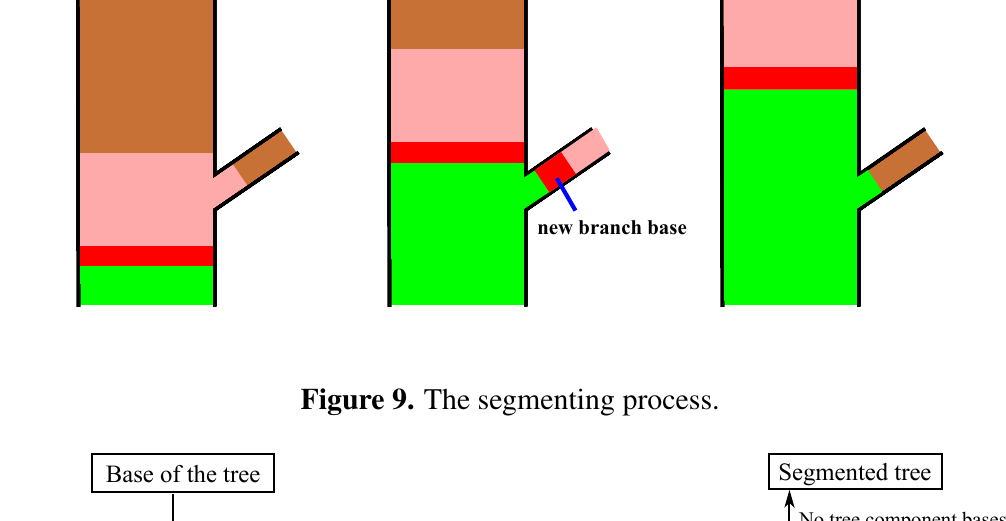
Figure 9. The segmenting